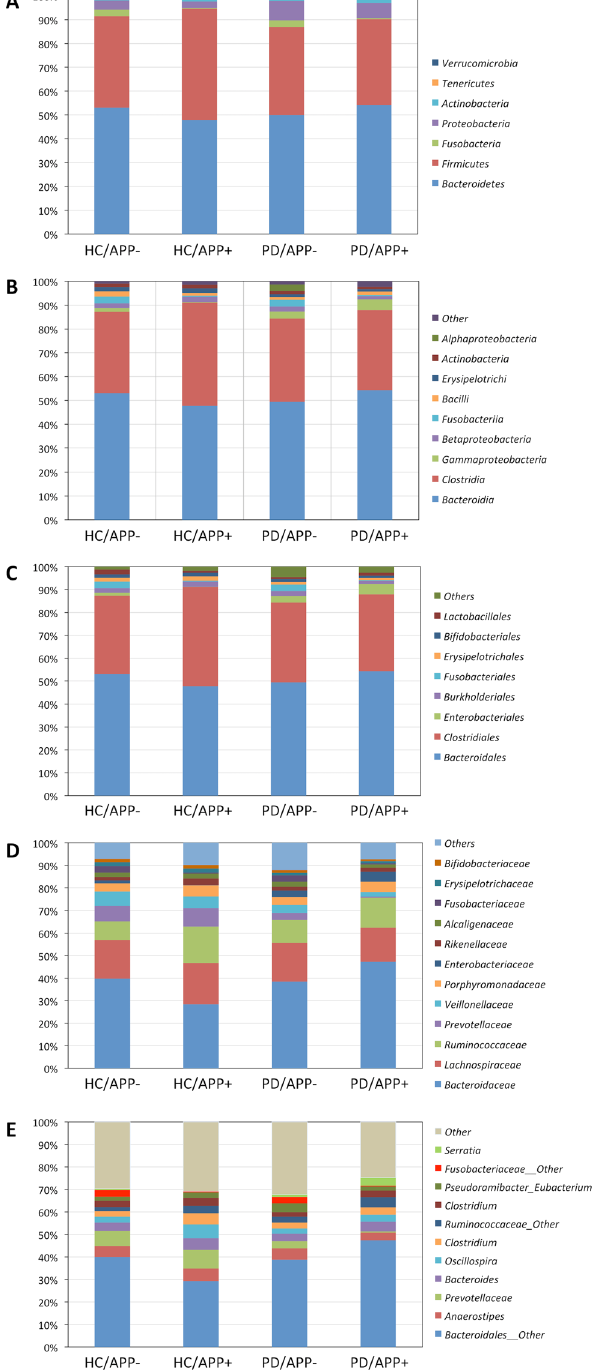
Figure 1. Microbiome profile analyses of average phylogenetic contents. Microbiome profile analyses at the phylum ( A ), class ( B ), order ( C ), family ( D ), and genus levels ( E ). HC/APP−, control without history of appendectomy (APP); HC/APP+, control with history of APP; PD/APP−, patient with PD without a history of APP; PD/APP+, patient with PD with a history of